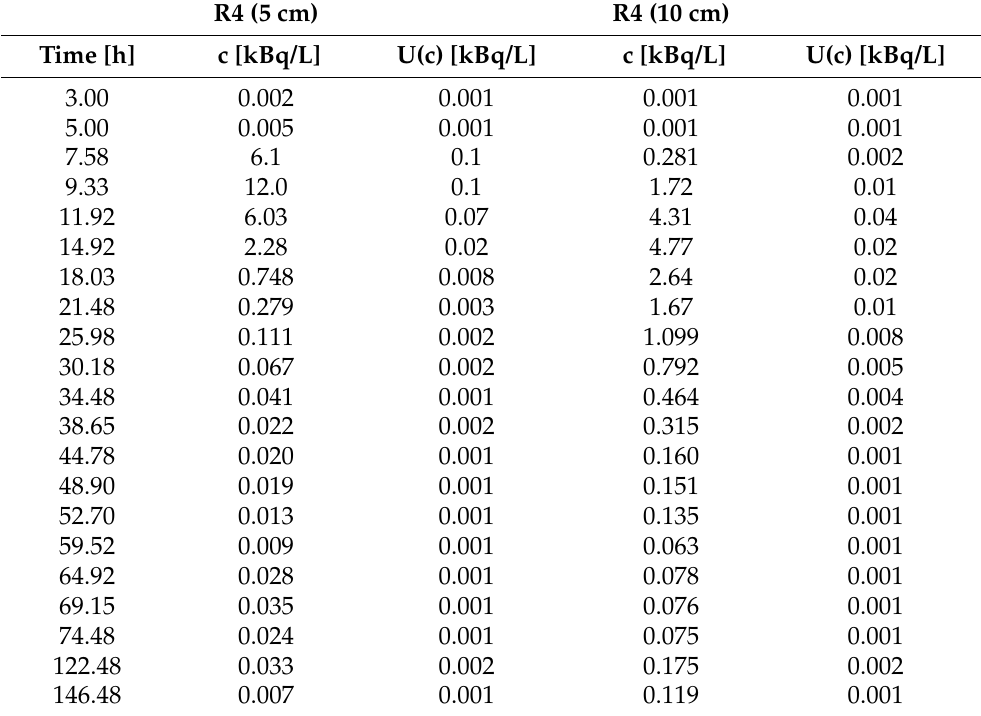
Table A4. Hyporheic 3 H activity concentrations and their analytical uncertainties at point